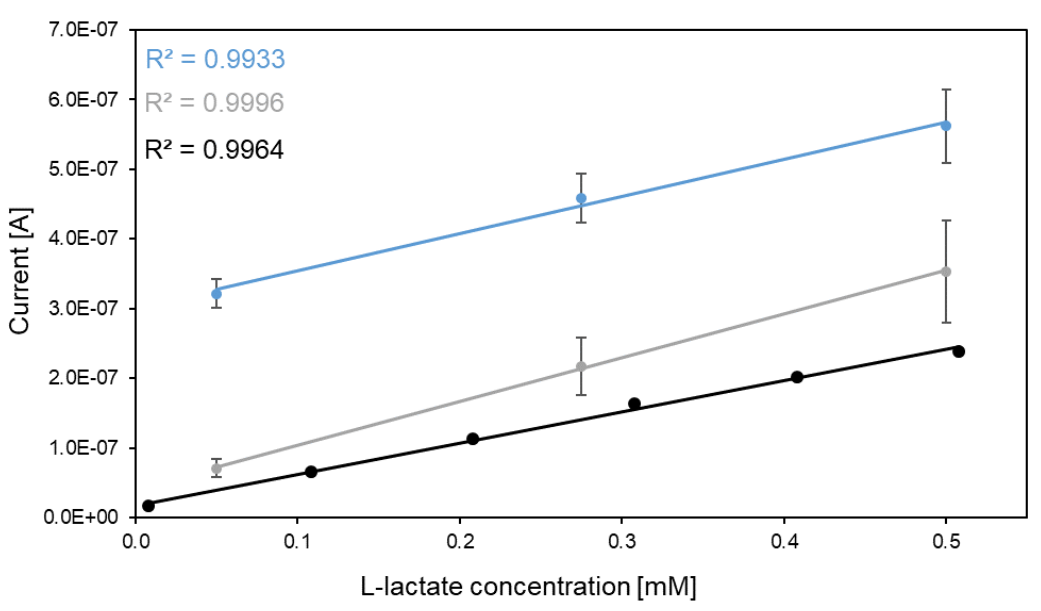
Figure A3. Example of biosensor calibration curve in CGXII medium diluted in PBS (blue line, n = 5), RPMI media (grey line, n = 5) and Fujifilm media (black line, n = 1).